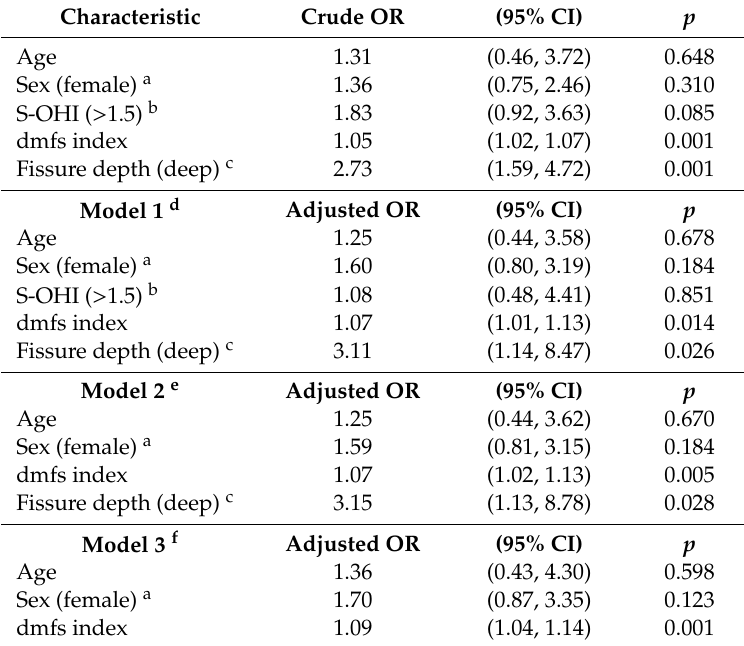
Table 4. Results of the bivariate and multivariate generalized estimating equation (GEE) models using baseline information of fissure depth, oral hygiene, and dental caries in primary teeth as predictor variables and the outcome variable incidence of dental caries (DMFS > 0), in schoolchildren followed-up for five